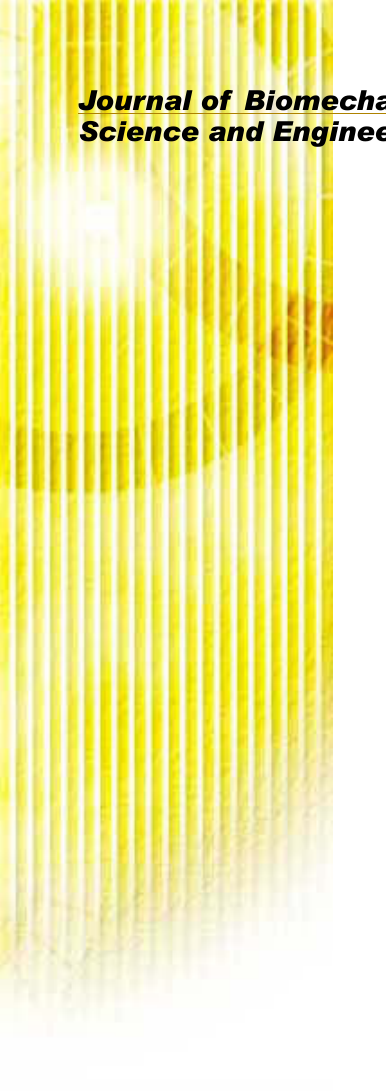
Fig. 3 Electrical stimulation to a rat quadriceps and measurement of quasi-isometric contraction force of the muscle. (a) Detection of muscle contraction force induced by electrical stimulation given through needle electrodes. Force transducer detects the muscle contraction force utilizing a nylon string, a cantilever, and strain gages. The cantilever was 56 mm in length, 10 mm in width, 1.5 mm in thickness, made of phosphor bronze. Two strain gages were pasted on both sides of cantilever at 50 mm from the free end. (b) Computer-controlled system able to perform simultaneously the electrical stimulation and the contraction force detection.